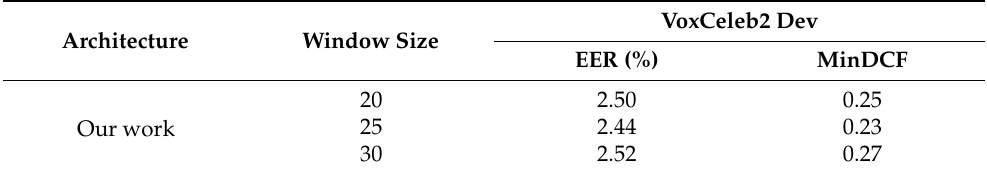
Table 2. The window size w changed from 15 to 30 frames.